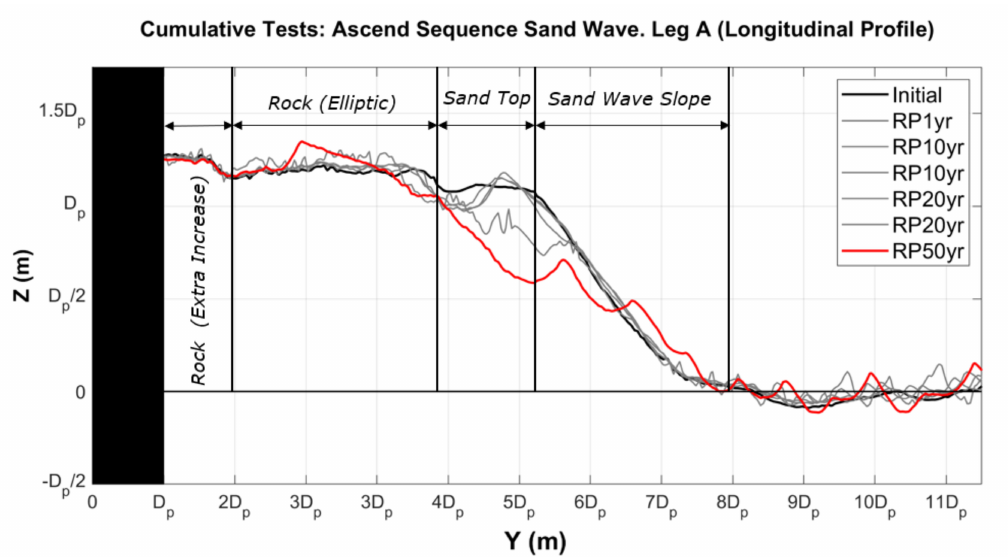
Figure 10. Longitudinal profile from the axis of leg A until the beginning of the sand